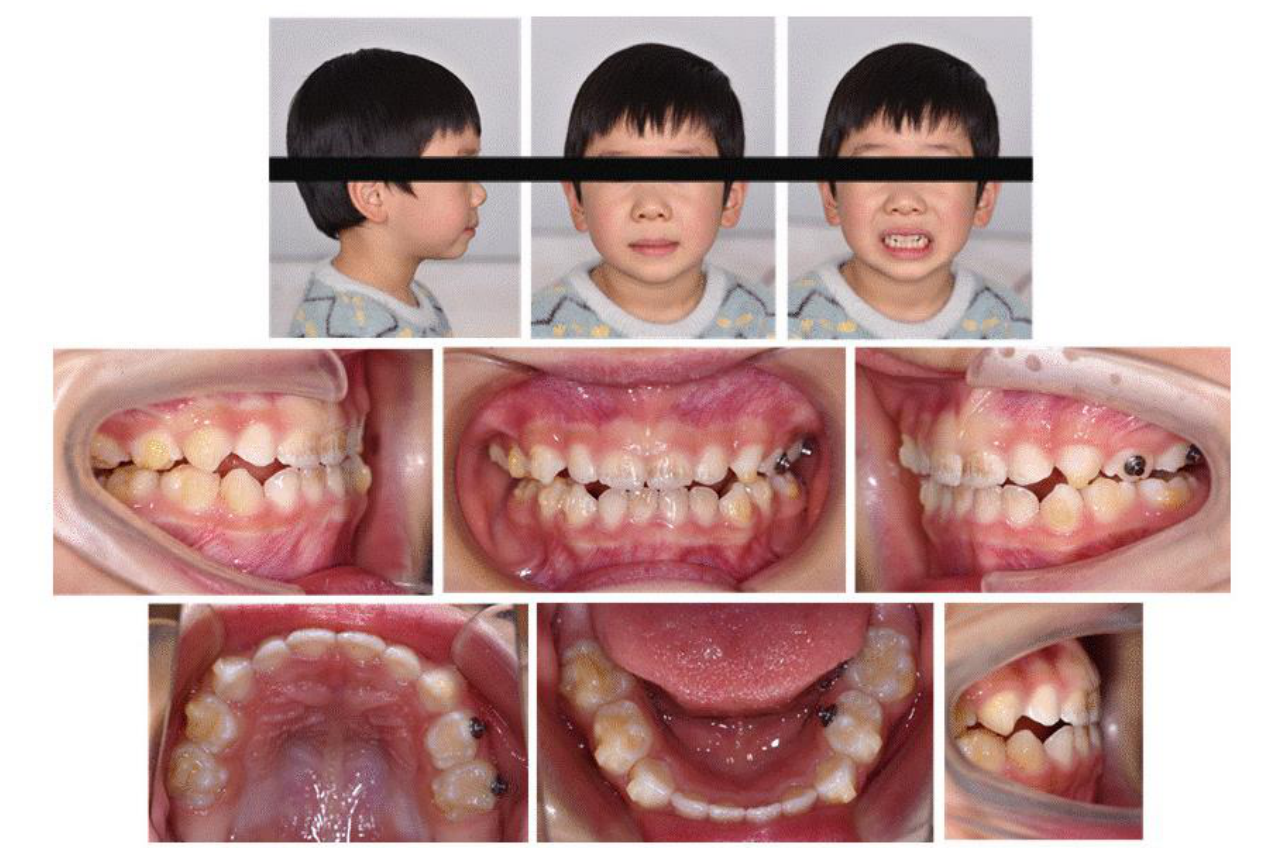
Figure 11. Intraoral photograph after the 20th aligner.